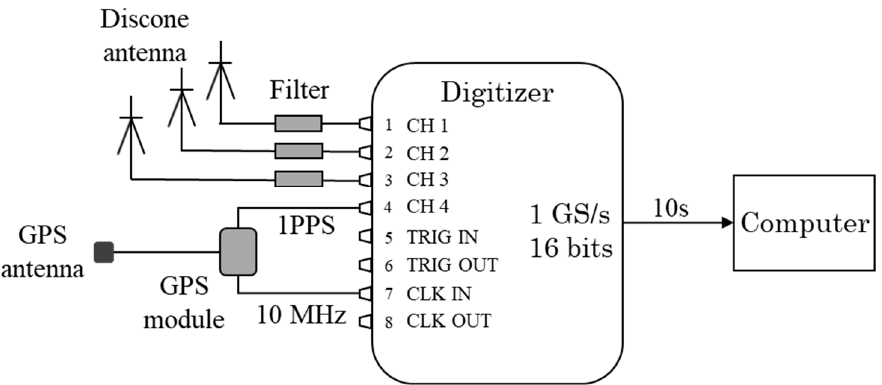
Figure 1. Schematic of the interferometer hardware at one station .